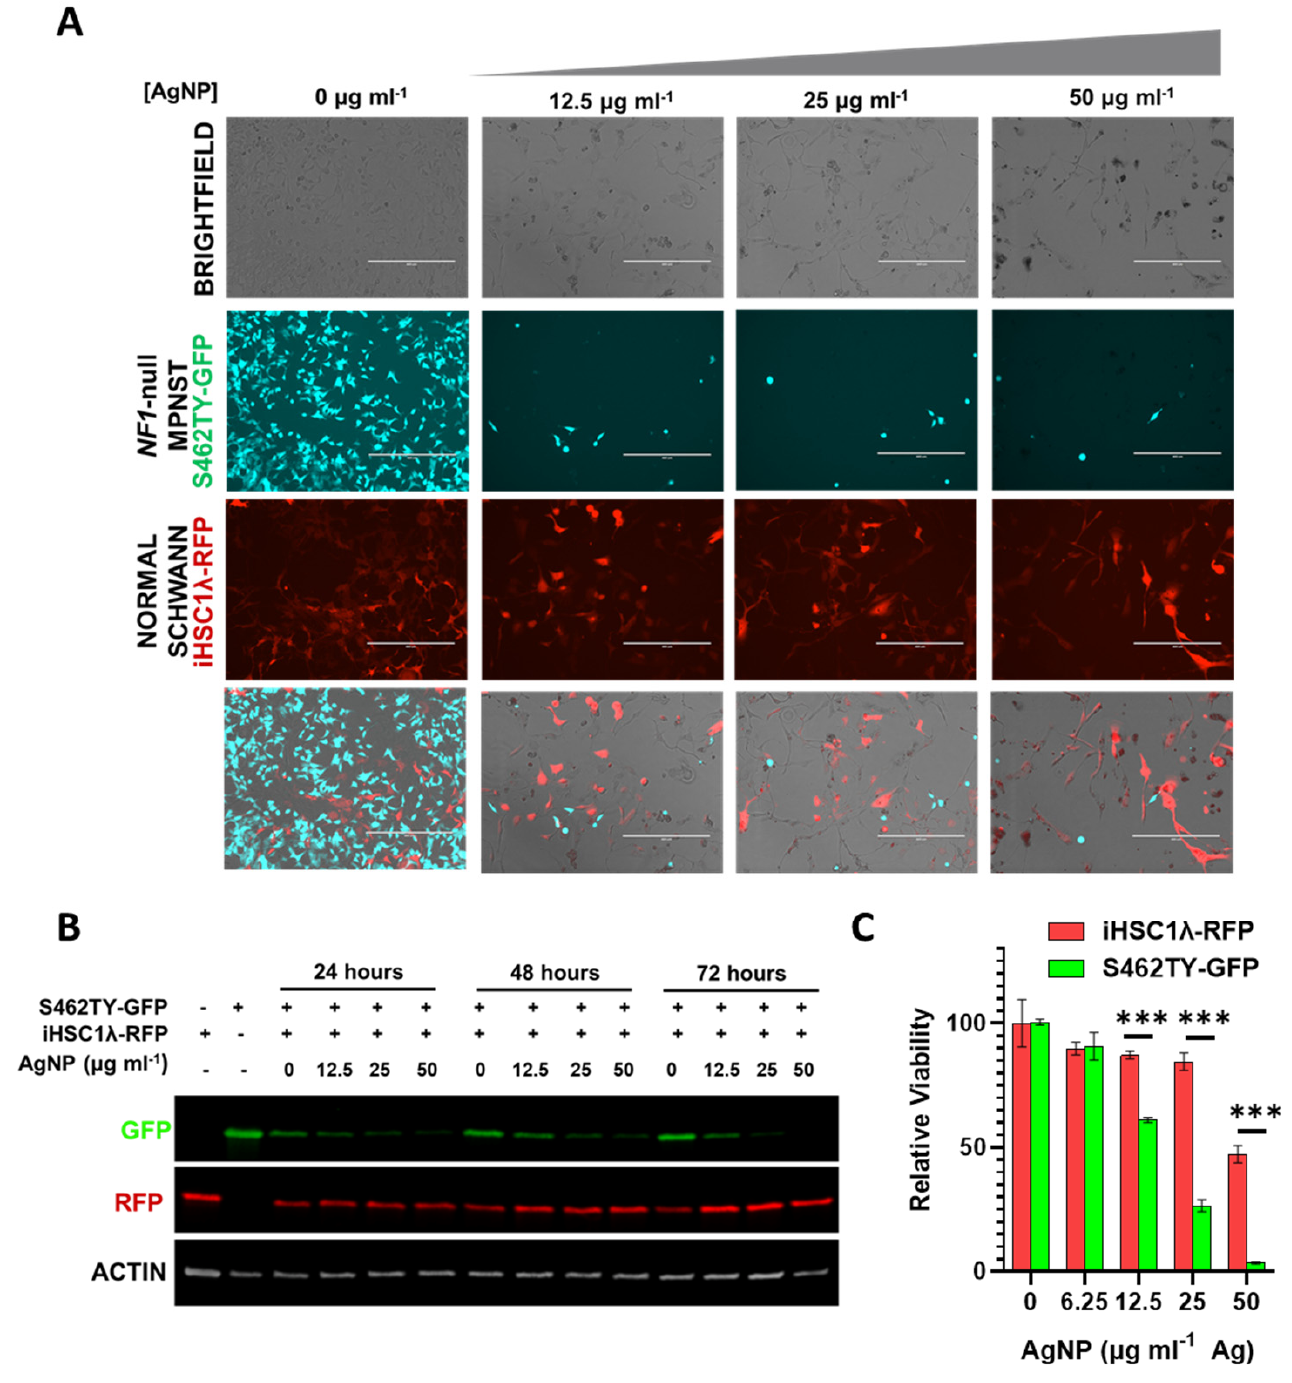
Figure 7. AgNP selectively removes NF1-associated MPNSTs from a co-culture with normal human Schwann cells. NF1-associated MPNST S462TY cells were transfected with a GFP expression vector, normal Schwann cell line iHSC λ 1 were transfected with a RFP expression vector, and stable pooled clones were propagated after puromycin selection. iHSC1 λ -RFP and S462TY-GFP were seeded at a 1:1 ratio and treated with AgNP (0–50 µ g mL − 1 Ag) for 0–72 h. ( A ) Representative images are shown after 72-h treatment with AgNP. ( B ) Cells treated as indicated were lysed and the protein was subjected to immunoblot assay for GFP, RFP, and actin control. ( C ) iHSC1 λ -RFP and S462TY-GFP monocultures were treated with AgNP for 72 h, and viability was assessed by MTT. *** p <